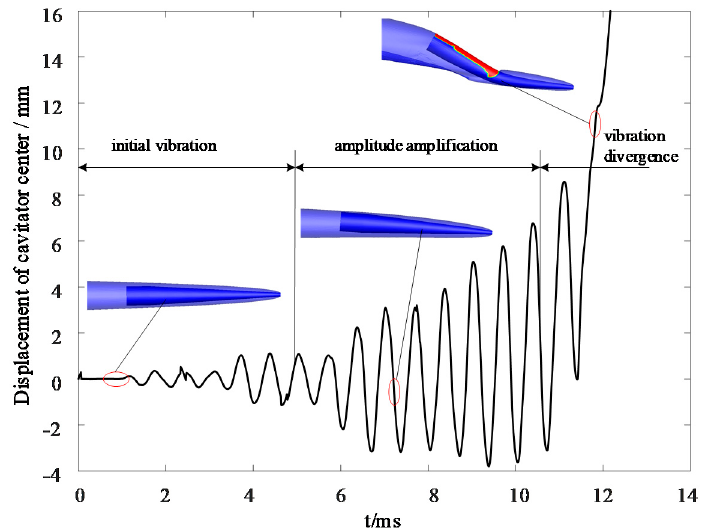
Figure 7. Vibration characteristics of cavitator center by considering FSI effect (1600 m/s).